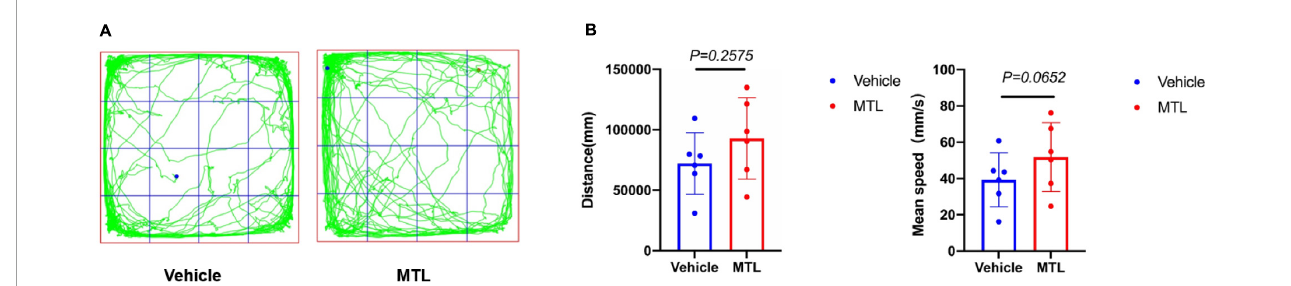
FIGURE8 (A) Trajectory chart of rats with intrathecal injection of 25 µ l of normal saline (group Vehicle) and 25 µ g of MTL (group MTL) during 30-min period. (B) Distance (mm) and mean speed (mm/s) of rats during 30-min duration in the control (Vehicle) and MTL group (MTL) in the open field testing 2 h after injection. n = 6 rats/group. Group Vehicle vs. group MTL, P < 0.05,